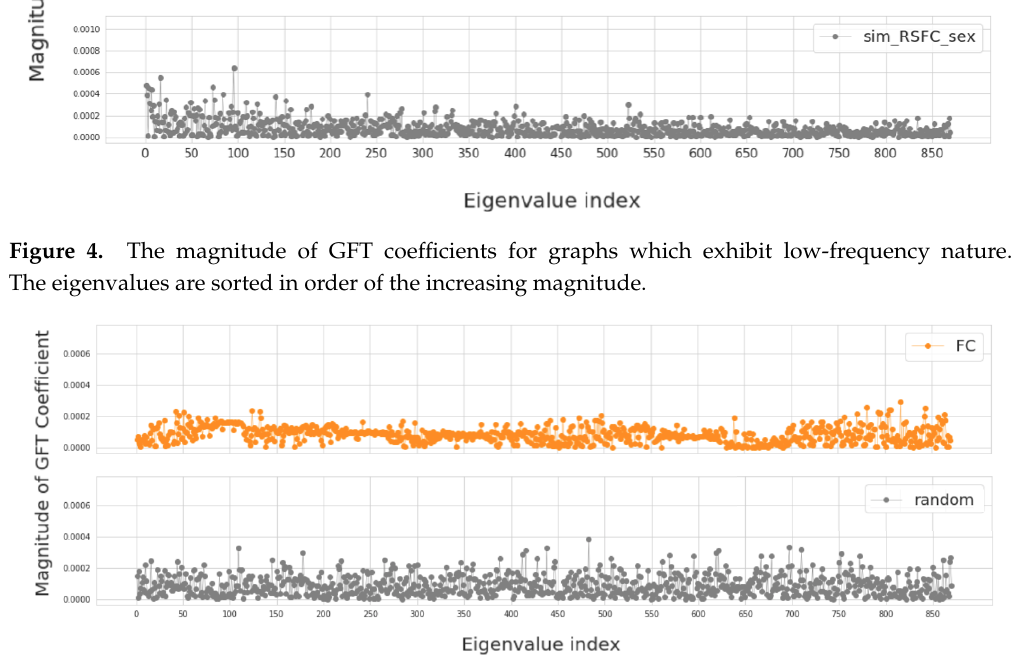
Figure 5. The magnitude of GFT coefficients for graphs which do not exhibit low-frequency nature. The eigenvalues are sorted in order of the increasing